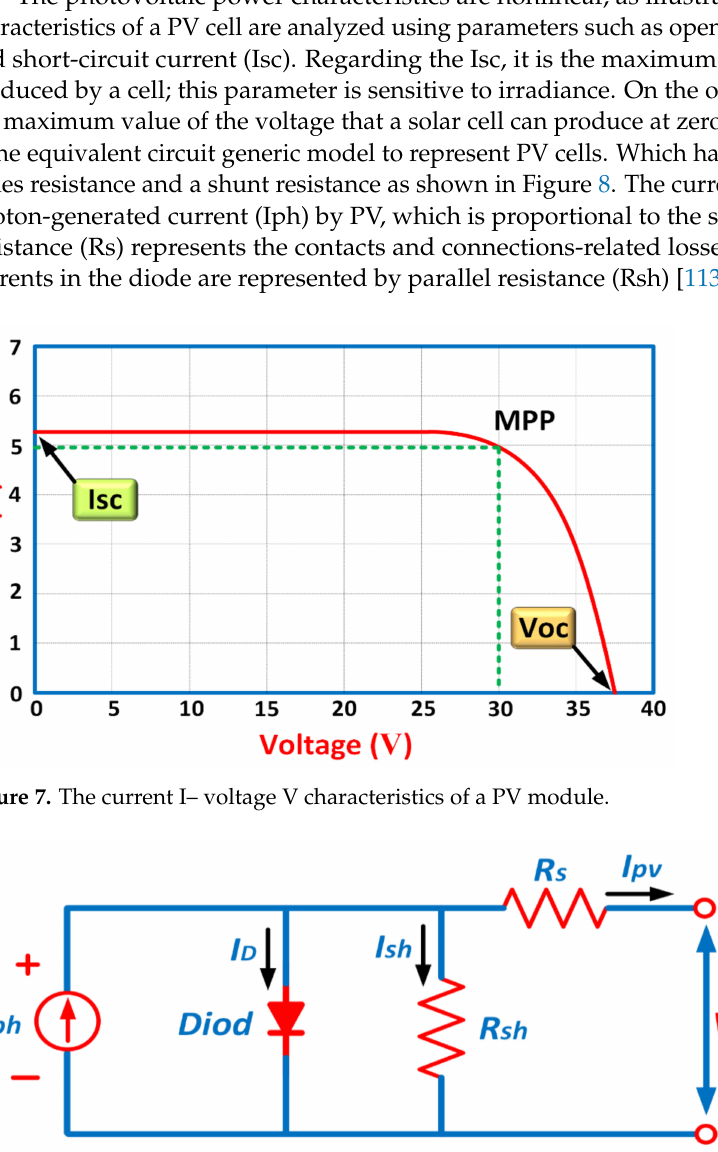
Figure 8. The equivalent circuit of PV